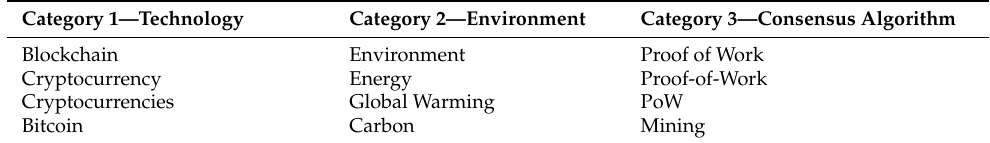
Table 1. Keyword Search Criteria.